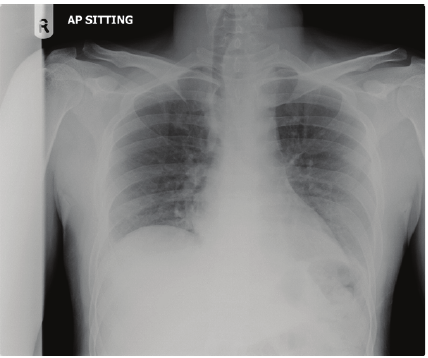
Figure 1: Chest radiograph showing tracheal deviation but other- wise unremarkable.